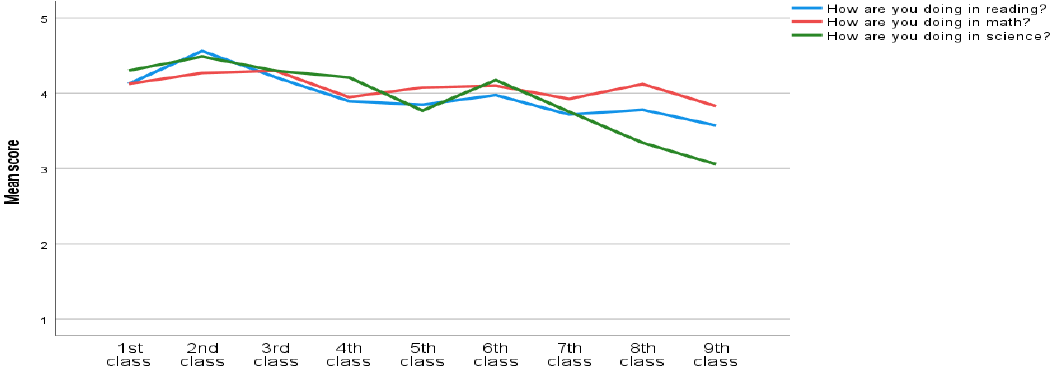
Figure 3. How are you doing in reading, math and science?